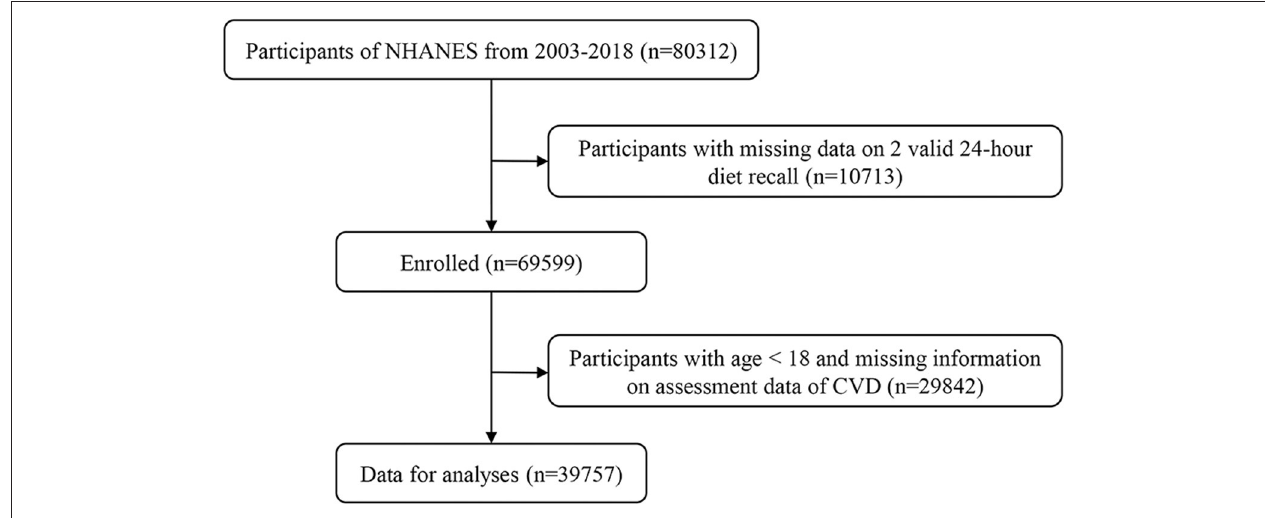
FIGURE 1 | Study flow diagram.